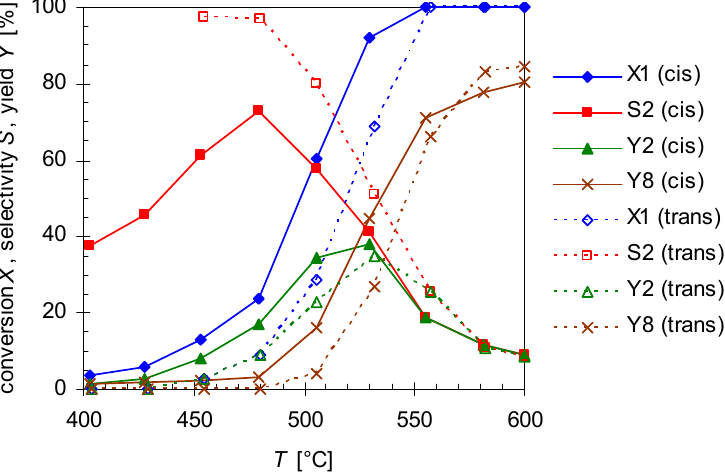
Figure 3. Temperature dependency of pinan-2-ol conversion X selectivity S (squares), linalool yield Y 2 pyrolysis of cis - (solid line) and trans - 1 (dotted lines). Reaction conditions: 30 µL 1 , carrier gas: N , flow rate: 0.8 L min − 1 , τ : 0.6–0.8 2